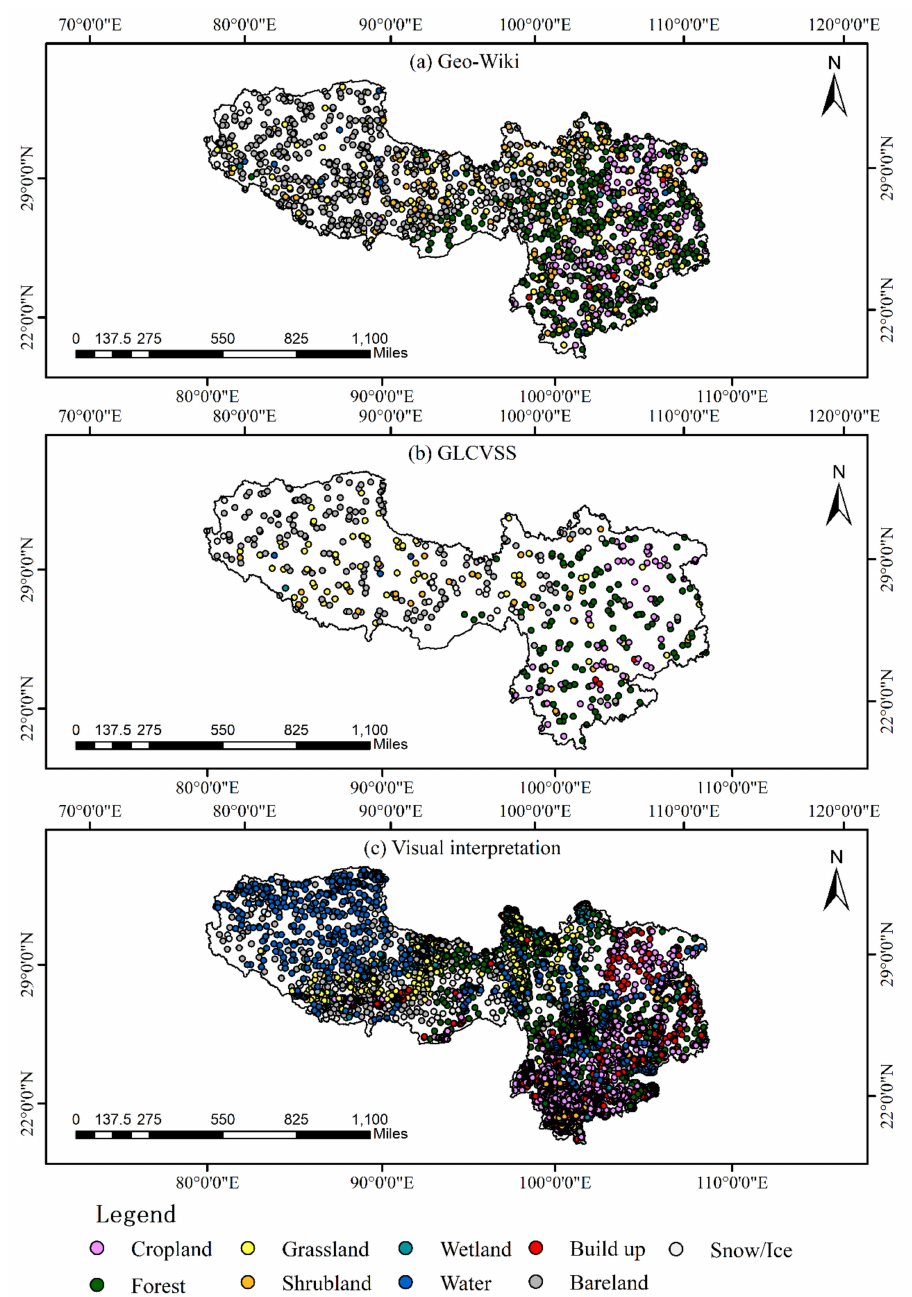
Figure 4. The spatial distribution of validation samples. ( a ) Geo-Wiki, ( b ) GLCVSS, and ( c ) Vis- ual